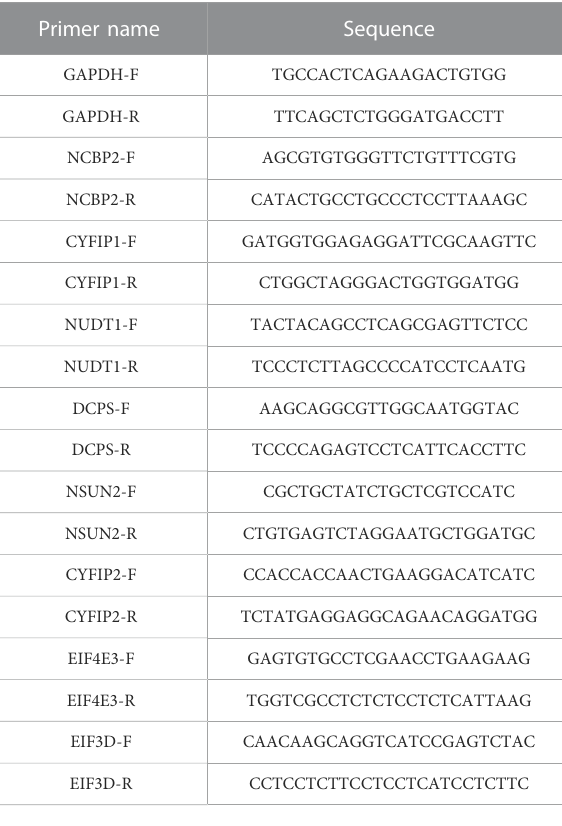
TABLE 1 Speci fi c primers used for quantitative real-time